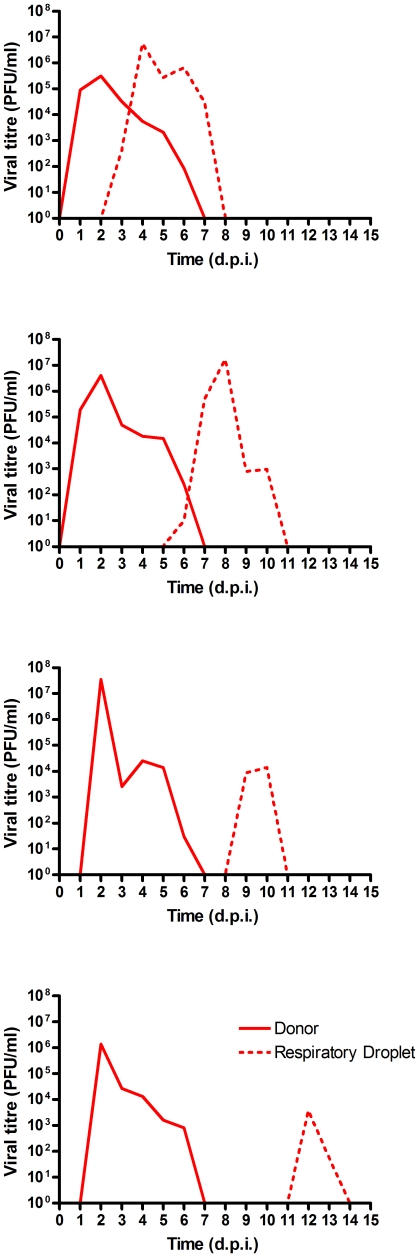
Transmission of E195 E227A in contact and respiratory droplet sentinels.Viral titres in nasal wash samples of ferret sets, each pair contained one donor (solid lines) and one respiratory droplet (dotted lines). Donors were inoculated with 104 PFU E195 E227A. Samples were taken daily and viral titres were determined by standard plaque assay on MDCK cells.